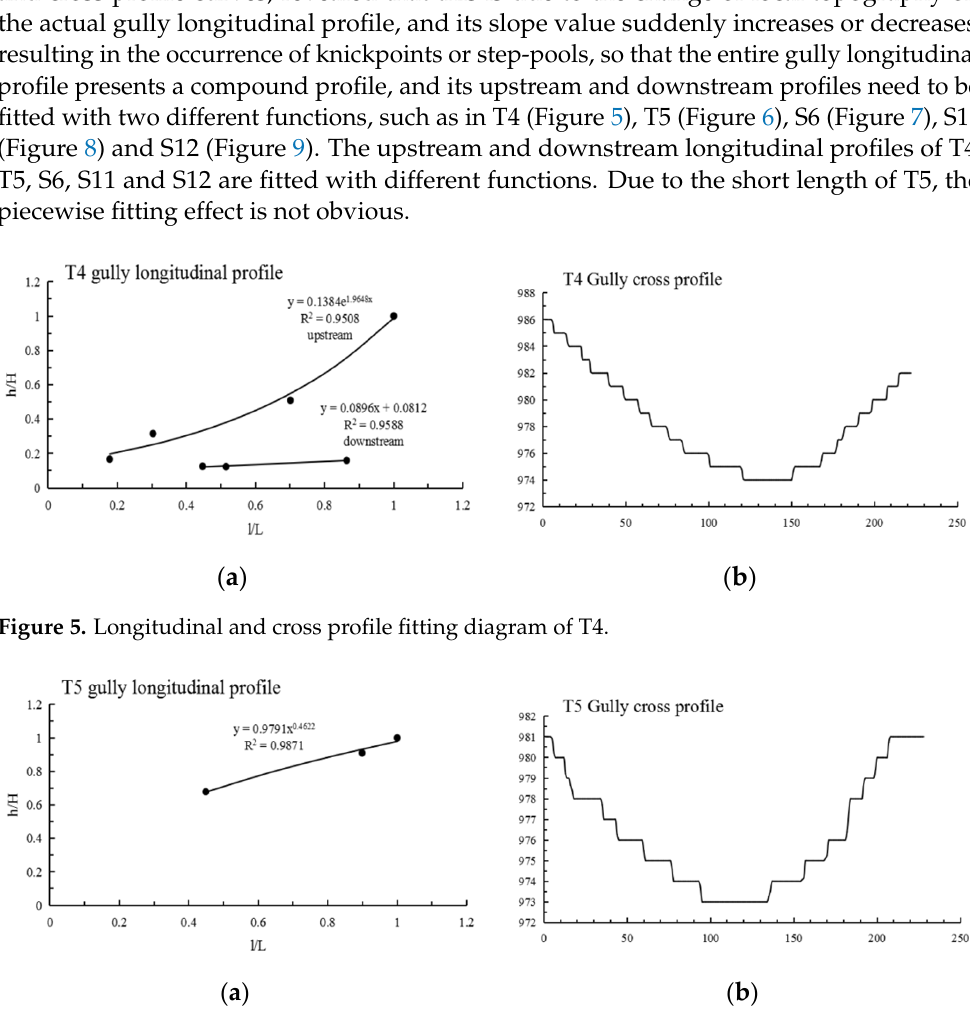
Figure 8. Longitudinal and cross profile fitting diagram of S11.